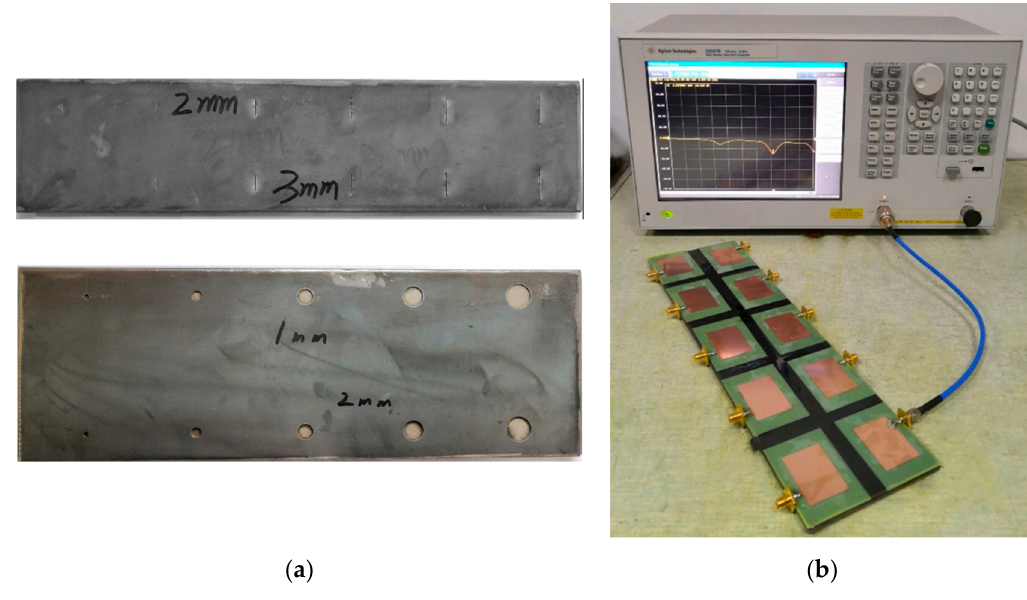
Figure 15. Experiment setup. ( a ) Sample and ( b ) experiment platform.